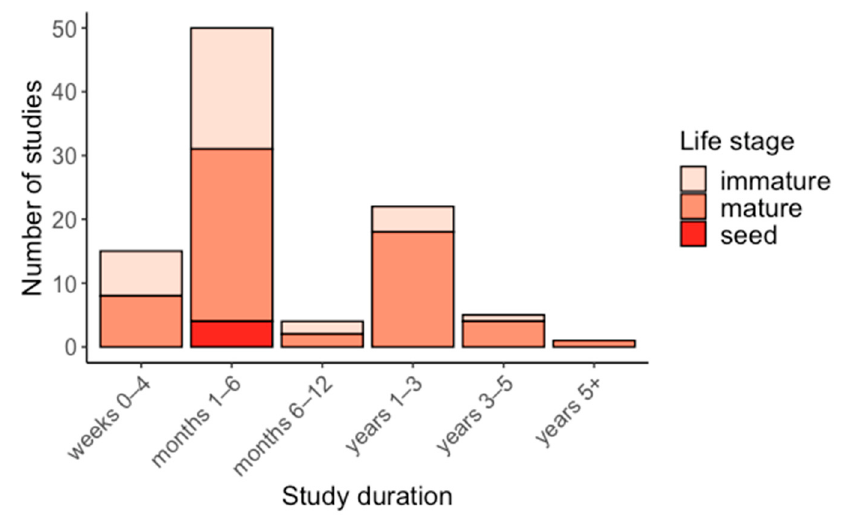
Figure 3. Duration of water supply reduction studies, grouped by life stage.